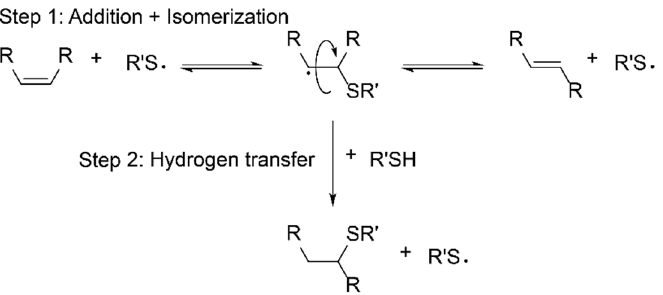
Figure 1. Propagation steps of the thiol-ene reaction, the first step including thiol addition via cis– trans isomerization comprising an addition–isomerization–elimination process, the second step being the rate-determining hydrogen abstraction from another thiol molecule.